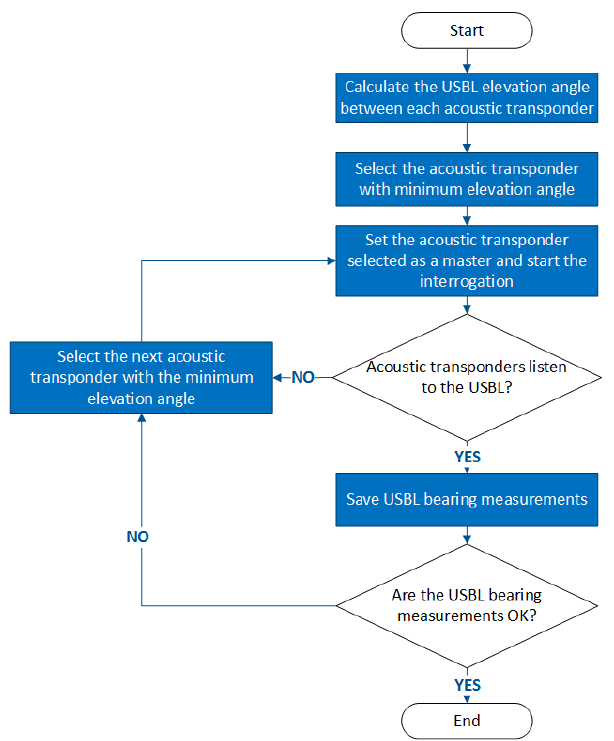
Figure 8. Flowchart of the dynamic master selection